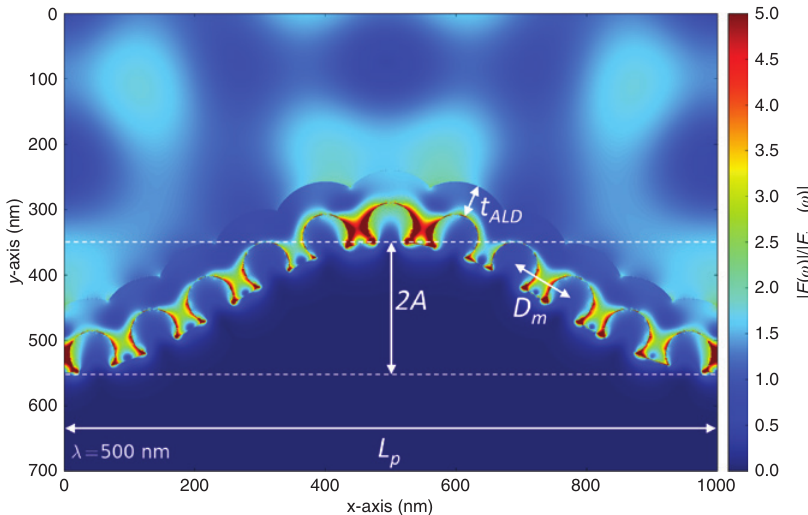
Figure 7: Simulation setup and computed near-field for NPs on a sine-modulated surface covered with a film of alumina. = 500 nm under x -polarised excitation for L Electric field (magnitude) distribution at λ 0 = 50 nm. The xy plots are taken through the centre of the spheres. This figure is extracted from Media 1, which shows A = 100 nm, t ALD the field distribution as a function of the